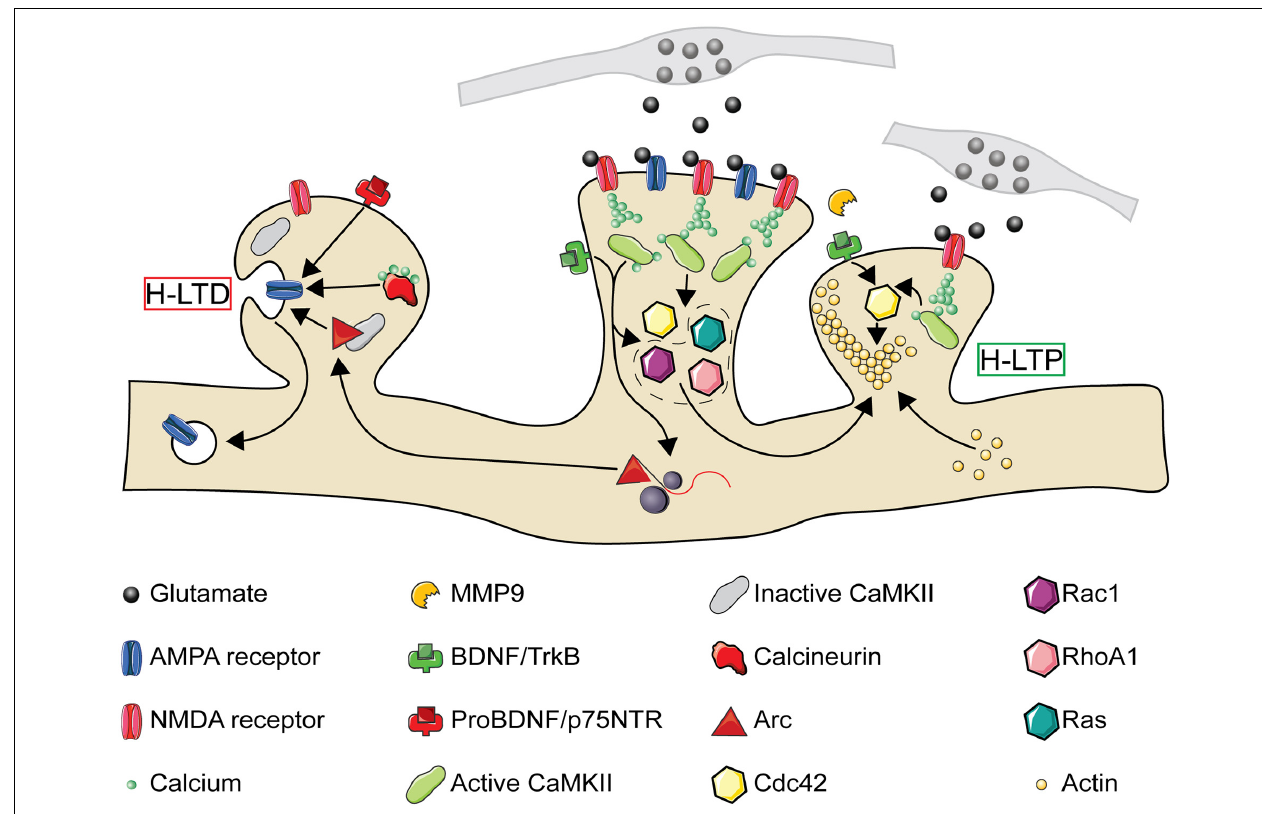
FIGURE 3 | The molecular pathways of heterosynaptic potentiation and depression. A Simplified representation of the molecular pathways through which homosynaptic potentiation (center spine) can drive heterosynaptic depression (H-LTD, left spine) and heterosynaptic potentiation (H-LTP, right spine) of neighboring synaptic spines. At the central spine, presynaptic glutamate release activates postsynaptic AMPA and NMDA receptors. NMDA receptor activation leads to calcium entry into the synapse, which in combination with calmodulin leads to CaMKII activation. CaMKII activation results in the activation of Ras and RhoA1, and in combination with TrkB activation through BDNF also the activation of Cdc42 and Rac1. Both CaMKII and BDNF activation may also result in the local translation of Arc mRNA present from previous bouts of activity. While activated Cdc42 remains confined to the activated spine, Ras, RhoA1, Rac1, and Arc spread along the dendritic shaft with the potential to interact with neighboring spines. If a nearby spine is inactive (left), Arc is recruited to the spine by an interaction with inactive CaMKII β . Small influxes of calcium, insufficient to activate CaMKII, can activate calcineurin. Release of proBDNF by the activated spine, in the absence of MMP9, can also result in binding of proBDNF to p75 neurotrophin receptors (p75NTR). Each of these processes can promote either structural spine shrinkage or the endocytosis of surface AMPA receptors, leading to H-LTD. If a neighboring synapse is instead activated (right, activation either simultaneous with or following the center spine), MMP9 promotes cleavage of proBDNF to BDNF which binds to TrkB receptors. This, in combination with NMDA receptor driven CaMKII activation, leads to Cdc42 activation. Cdc42 activation by a subthreshold stimulus, in combination with the spread of activated Ras, RhoA1, and Rac1 from the center synapse, drives the remodeling of the actin cytoskeleton leading to structural H-LTP. CaMKII, Ca 2 + -calmodulin-dependent protein kinase II; MMP9, matrix metalloproteinase 9. Image assets reproduced from smart.servier.com (Servier Medical Art, 2015)